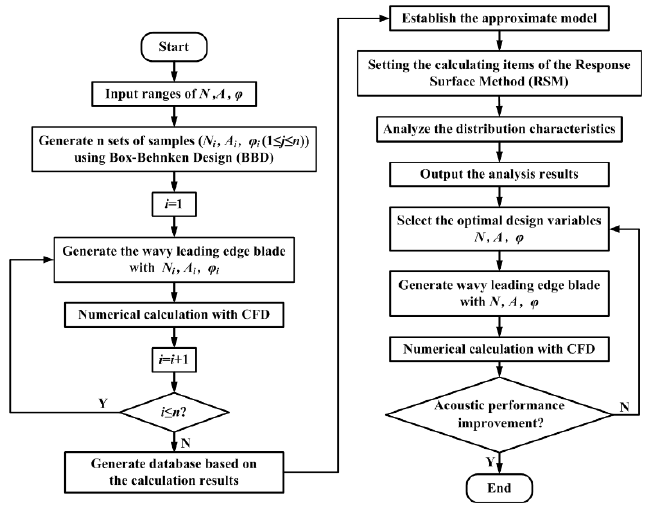
Figure 8. Flow chart of optimization strategy.